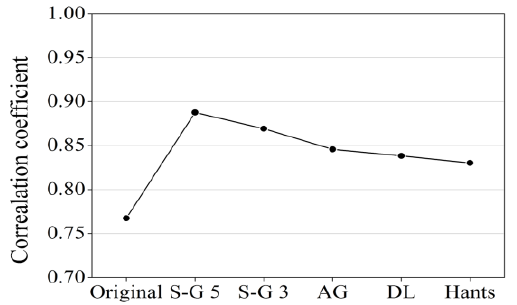
Fig. 6: Correlation coefficient of the MODIS NDVI time series and the HJ NDVI time